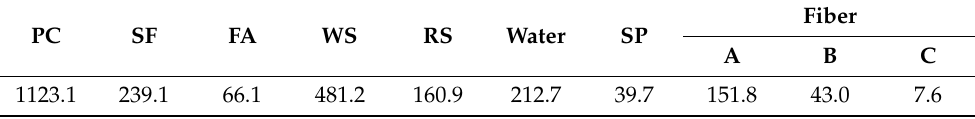
Table 4. Constituent materials of the UHPC (in kg/m 3 ).